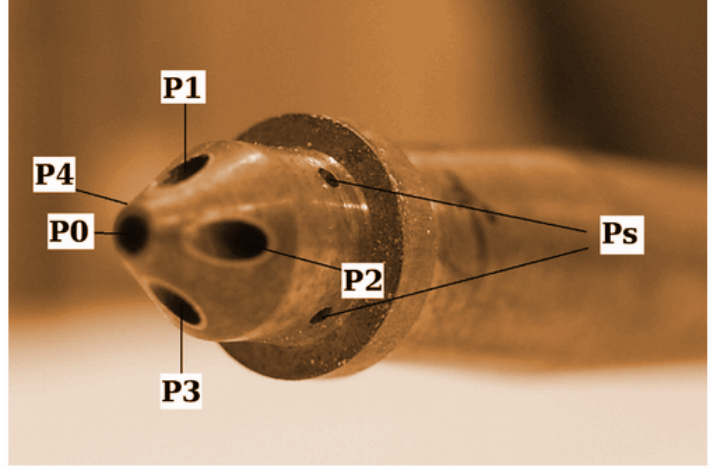
Figure 6. Multi-hole probe with a diameter of 6mm and its pressure ports designed and manufactured by the Institute of Fluid Dynamics (TU Braunschweig, Germany). Around the central hole P 0 on the tip, pairs of holes in the vertical ( P 1, P 3) and horizontal ( P 2, P 4) axis are visible. In front of the ring, the four small circumferential holes of the static pressure port Ps can be seen. Picture taken from